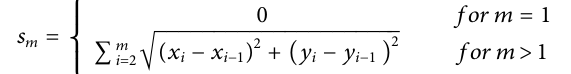
Frontiers in Robotics and AI |